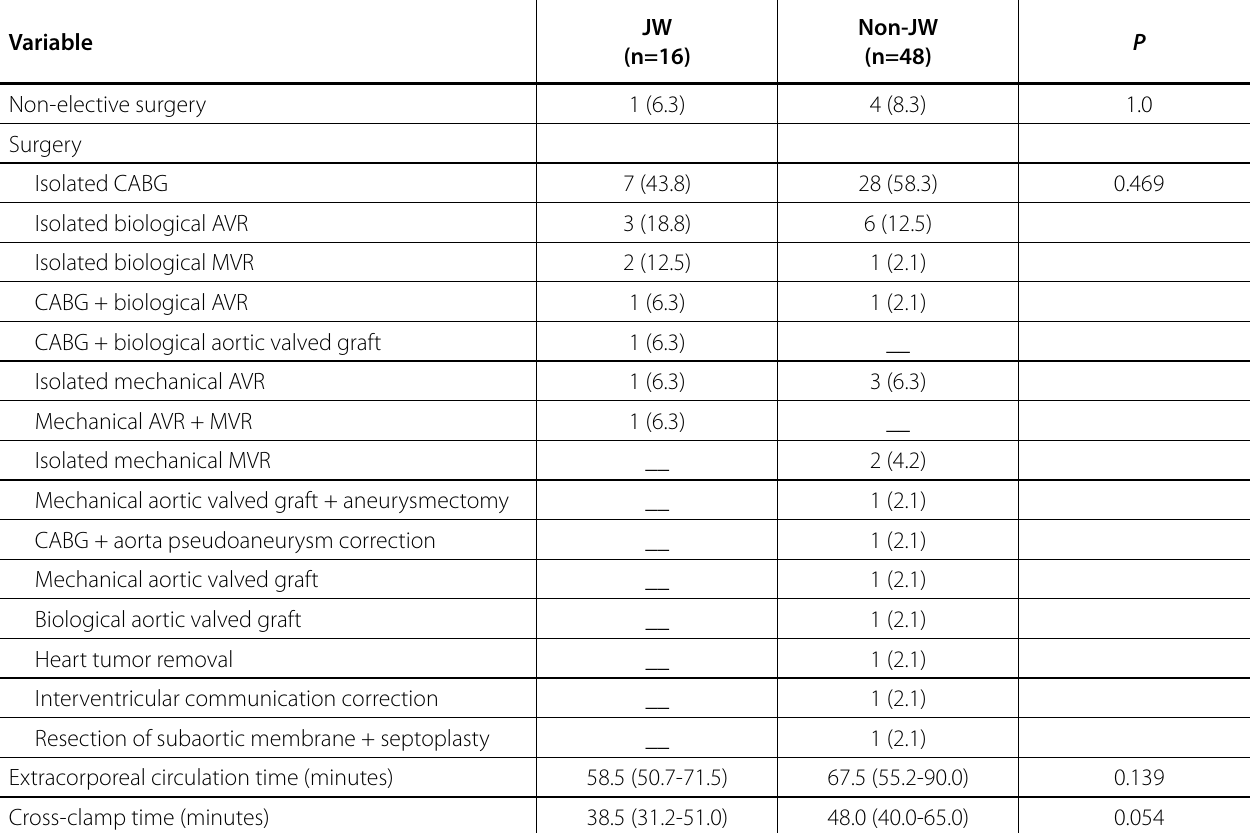
Table 2. Surgical data. Variable